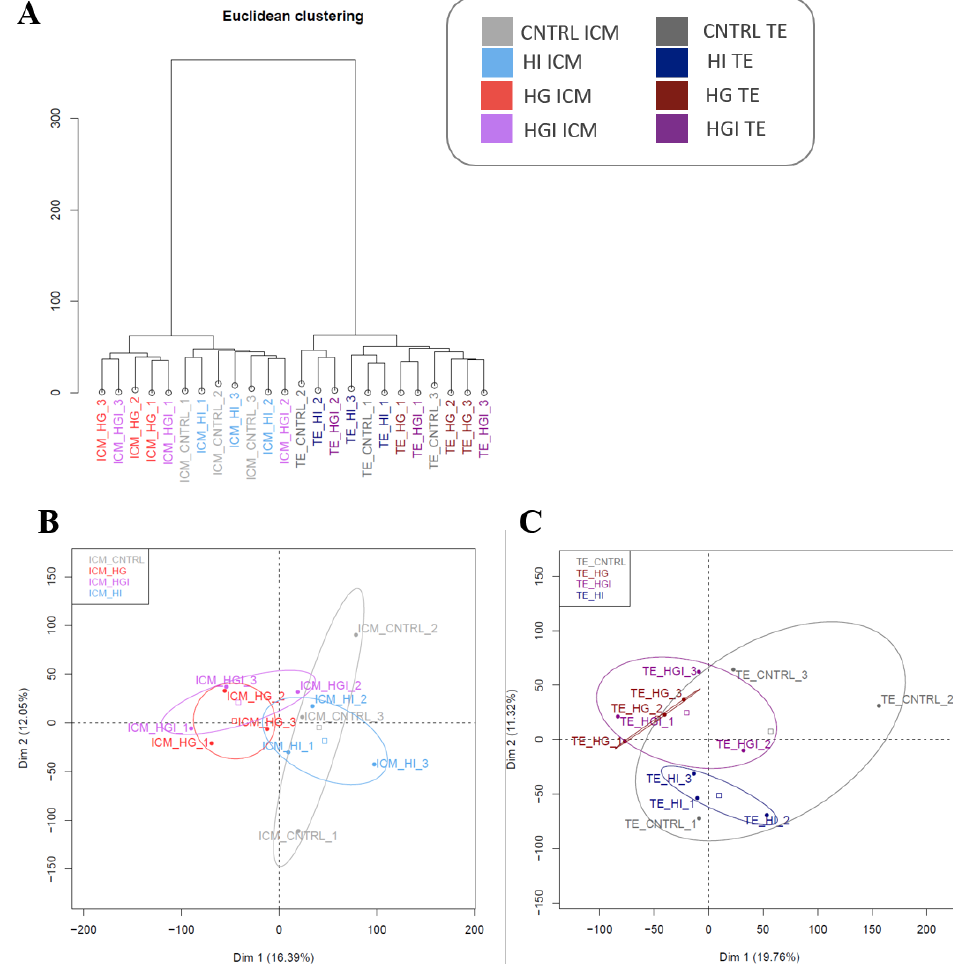
Figure 2. Transcriptome analysis of isolated ICM and TE from in vitro-developed blastocysts with high glucose and/or high insulin. ( A ). Clustering by Euclidean distance of the transcriptomic datasets of ICM and their corresponding TE developed in CNTRL, HI, HG, or HGI. Each group included three biological replicates which consisted of n = 11-16 ICM or TE. ( B ). Principal component analysis (PCA) of ICM groups. ( C ). PCA of TE groups. ICM, inner cell mass. TE, trophectoderm. CNTRL, control; HI, high insulin; HG, high glucose; HGI, high glucose and high insulin. Samples are color-coded according to the legend at the top (right).